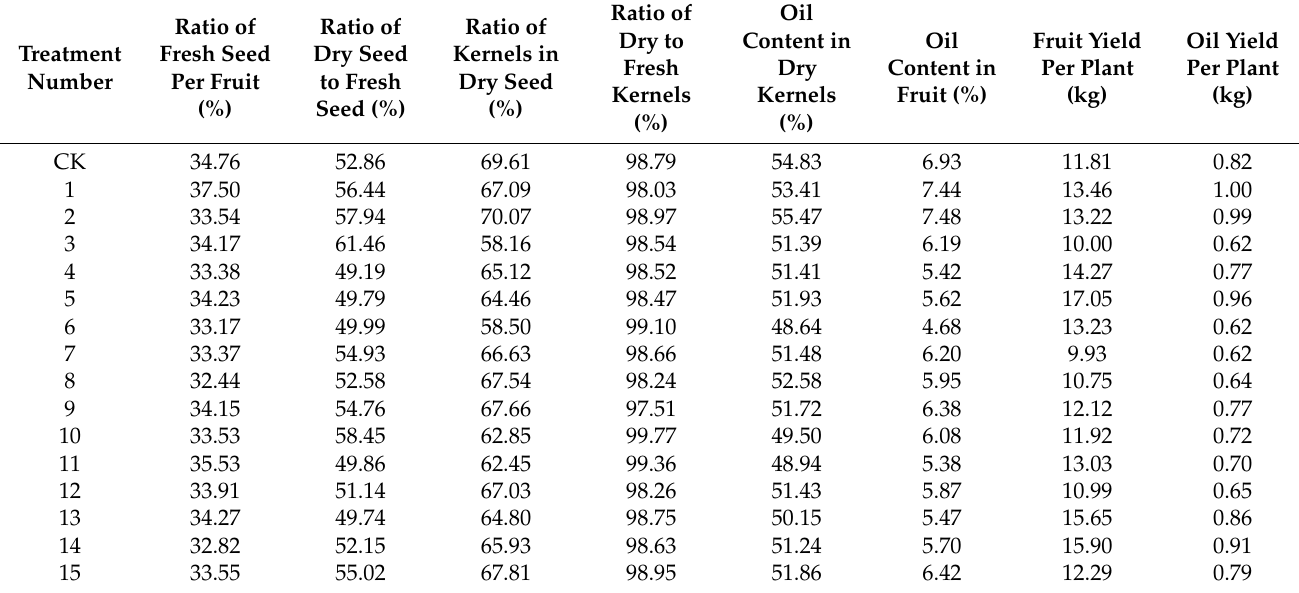
Table 3. Effects of trace elements on economic indicators for Camellia oleifera